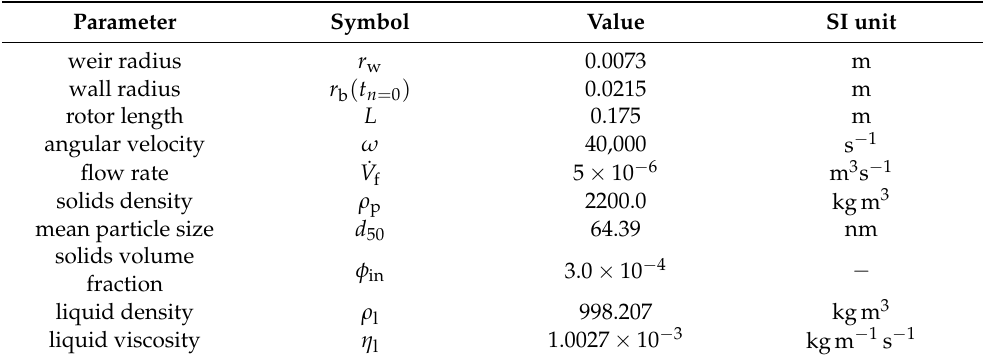
Table 1. Overview of the centrifuge geometry, fluid and particle system